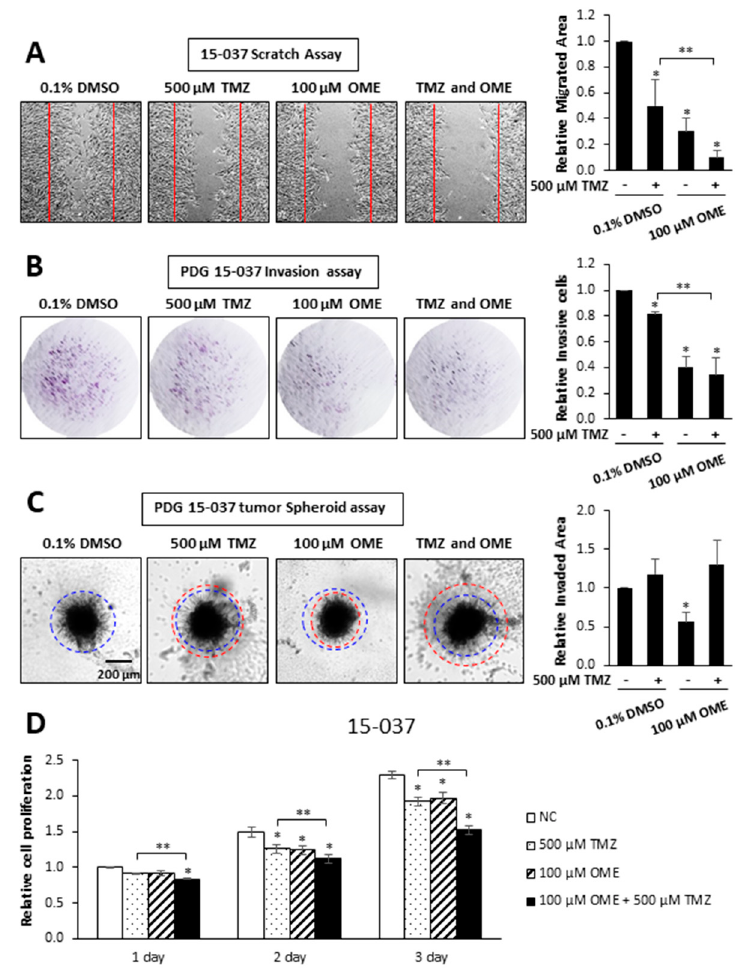
Figure 5. Comparative effects of OME and TMZ on cell migration, invasion and growth. 15-037 cells were treated with DMSO, 100 µM OME, 500 µM TMZ, and their combination and effects on cell migration ( A ), invasion in the Boyden chamber ( B ) and spheroid cell ( C ) assays and proliferation ( D ) were determined as outlined in the Materials and Methods. Results are expressed as means ± SD for at least 3 separate determinations for each treatment group and significant ( p < 0.05) inhibition by individual compounds (*) and enhanced inhibition by the drug combination (compared to TMZ) (**) are indicated.